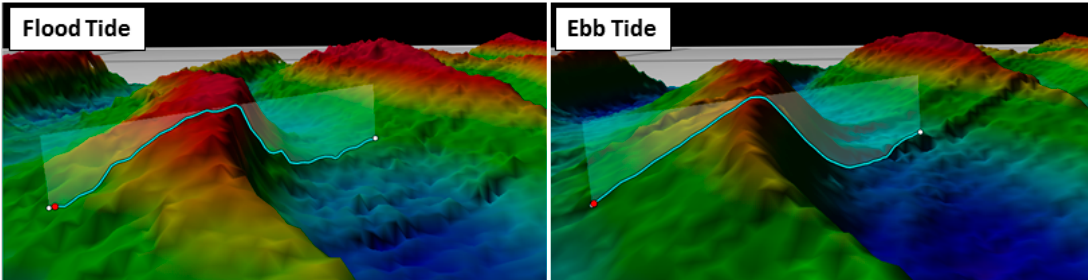
Figure 7. 3D models of a mega ripple found within the ROI of the Westdiep experiment (central ripple in Figure 6N; same peak flood and ebb times as in Figure 6K). Vertical exaggeration = 6 × . To verify the consistency of this pattern over the entire study area, profiles were extracted from the full transect; different sub-areas of the entire transect and at different angles i.e., nadir, oblique and fall-off angular regions of the swathe (not shown).